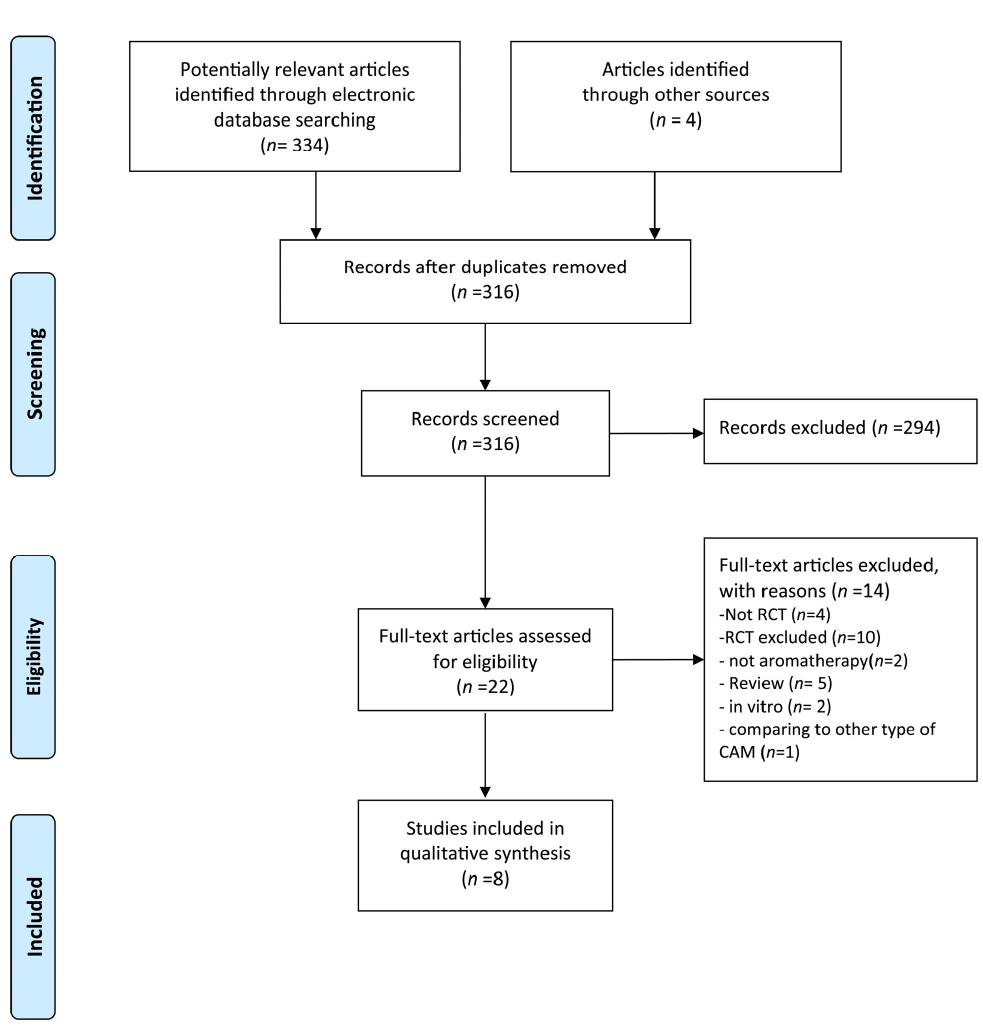
Figure 1. PRISMA diagram for the included studies. CAM: complementary and alternative medicine; RCT: randomized controlled trial.